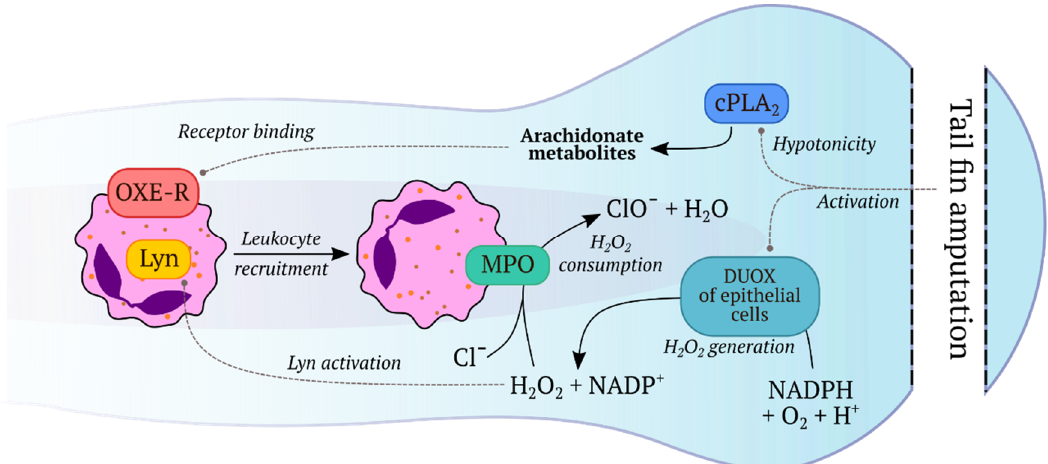
Figure 3. Inflammatory response in zebrafish larvae. Tail fin amputation leads to H 2 O 2 production and release of arachidonate metabolite in the injured tissue. These compounds are sensed by leukocytes and play an essential role in their recruitment to the wound. H 2 O 2 signal is dampened by arriving neutrophils as H 2 O 2 is consumed in a reaction catalyzed by myeloperoxidase (MPO) [57,68,141,271]. Deng et al. compared two inflammatory models, bacterial infection and tail fin amputation in D. rerio . According to their data, injection of the Pseudomonas aeruginosa PAK strain into the inner ear of larvae led to neutrophil accumulation in the inflammatory sites, though the HyPer signal did not significantly change. In larvae that were exposed to both bacterial infection and tail fin amputation, inhibition of Duox activity impaired neutrophil recruitment to the tail but not to the inner ear. This result suggests that during bacterial infection leukocytes are recruited by a mechanism independent of H 2 O 2 production [142].